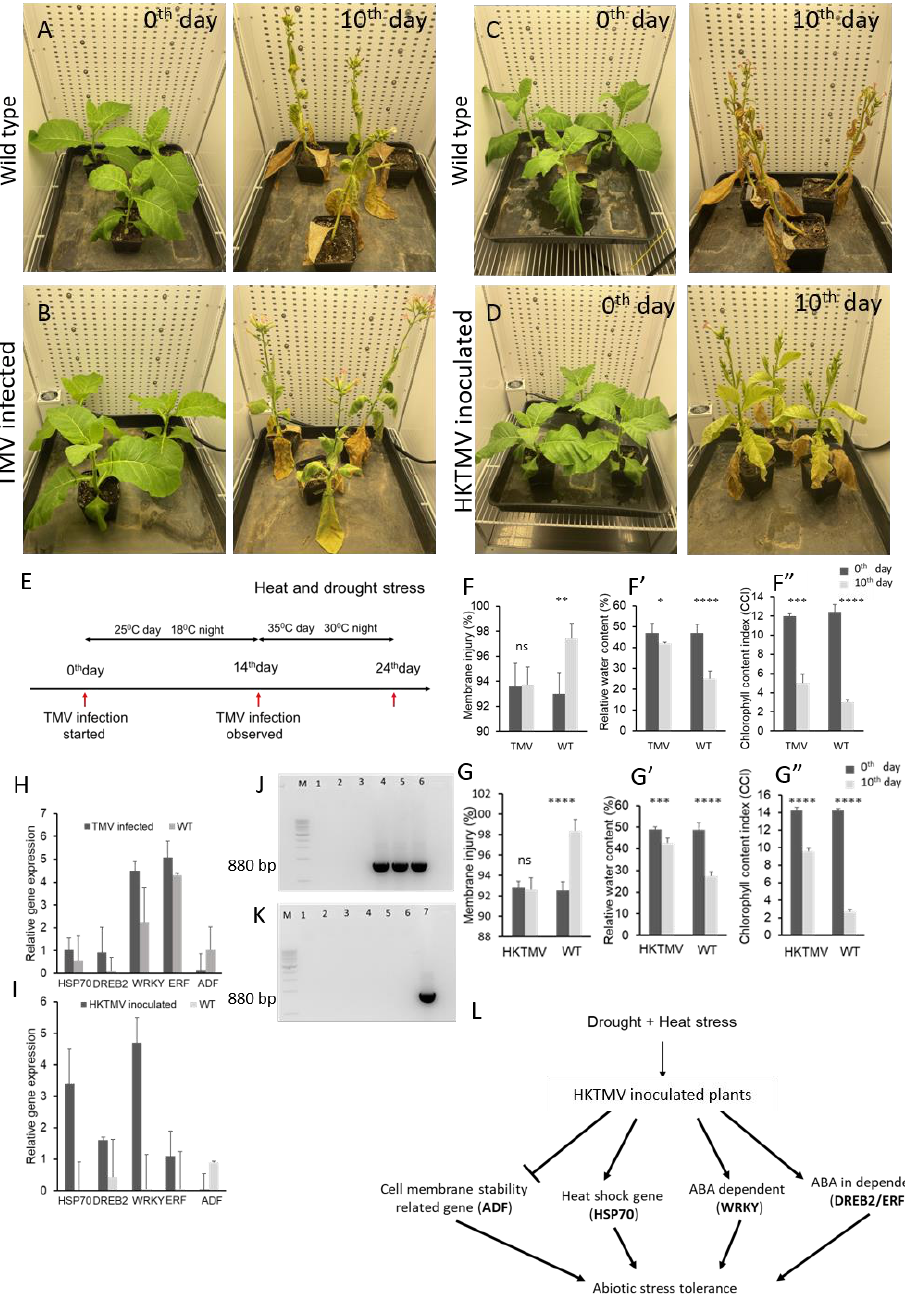
Figure 1. ( A ) Uninoculated control plants on days 0 and 10 of stress. ( B ) TMV-inoculated plants on days 0 and 10 of stress. ( C ) Uninoculated control plants on days 0 and 10 of stress. ( D ) HKTMV inoculated plants on day 0 and 10 of stress. ( E ) Schematic representation of the treatment procedure. ( F ) Membrane thermostability of TMV-inoculated and control plants on days 0 and 10 of drought and heat stress. Data labeled with ** p < 0.05 show a significant difference by the Student’s t -test. ( F’ )